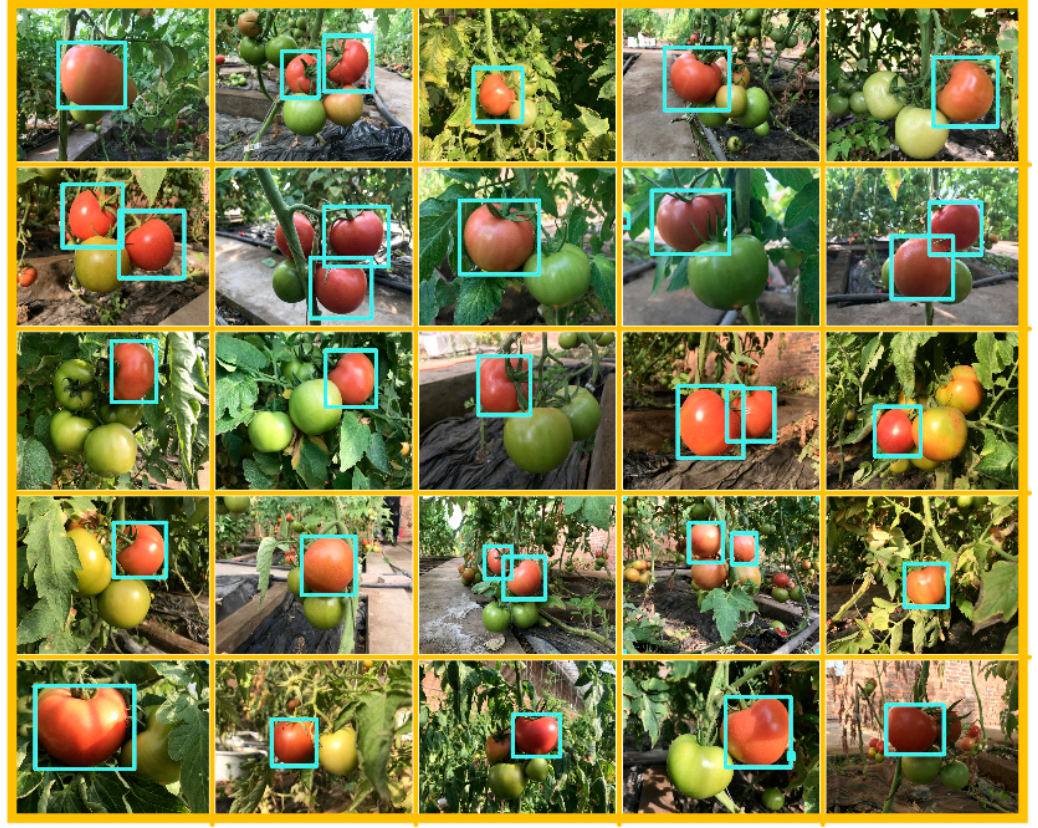
Figure 10. The testing results of the proposed algorithm.